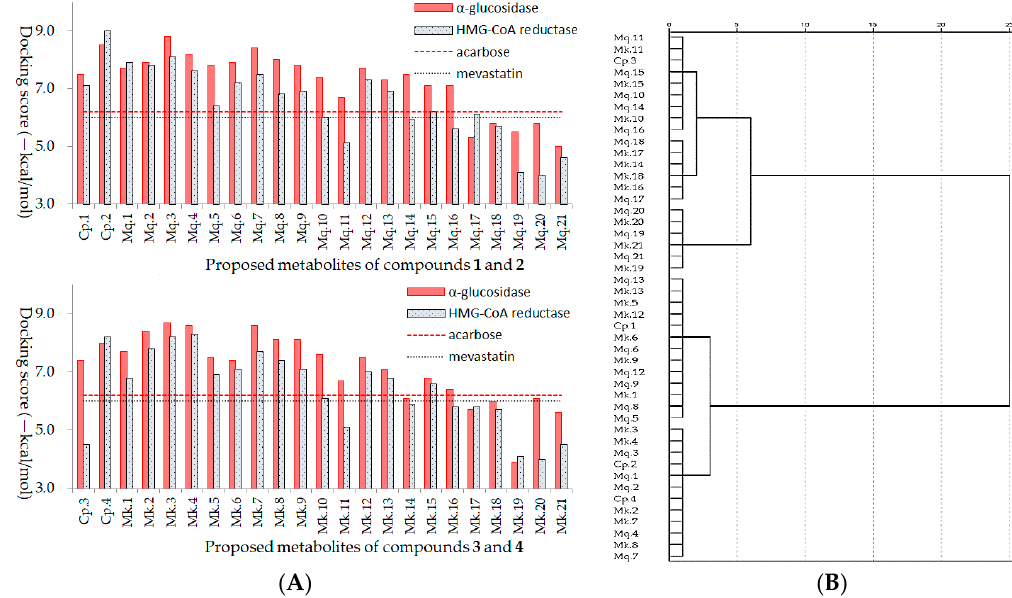
Figure 4. Trends analysis of metabolite inhibitory activities of acylglycosides flavones on α -glucosidase and HMG-CoA reductase ( A ), and clustering analysis of the homogeneity of the binding conformations ( B ).